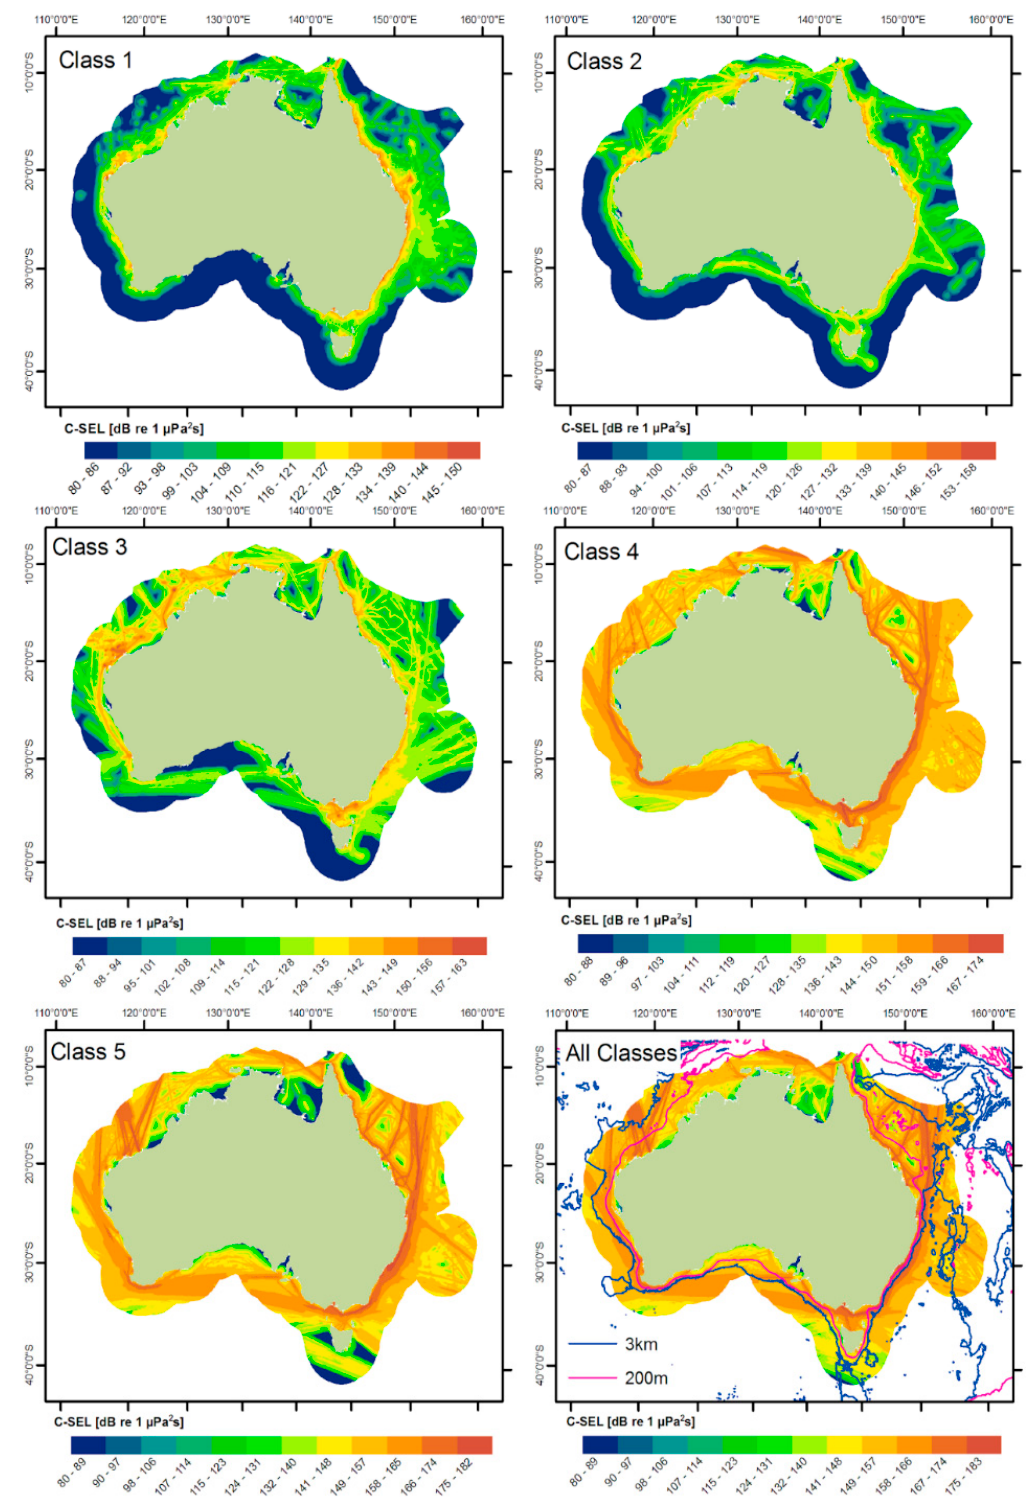
Figure 6. Maps of cumulative sound exposure levels (C-SEL) from shipping in the Australian EEZ, by ship class, and cumulatively over all classes. Maximum received C-SEL over the top 200 m of water were picked, representing a ‘worst case’ for animals that dive within this depth. Sound exposure was accumulated over 183 days (1 April 2015–30 September 2015). Levels can be converted to average mean-square sound pressure levels by subtracting 72 dB re 1 s. Note that the colour bars all start at 80 dB but the highest levels differ, reflective of the peak C-SEL for each class. The final map also shows 200 m and 3 km bathymetry contours.